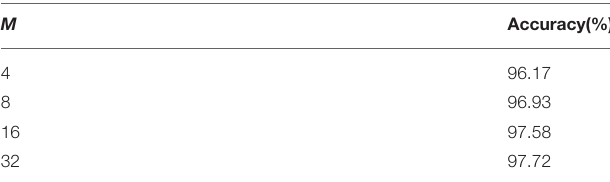
TABLE 7 | Classification accuracy of different numbers of attention maps on